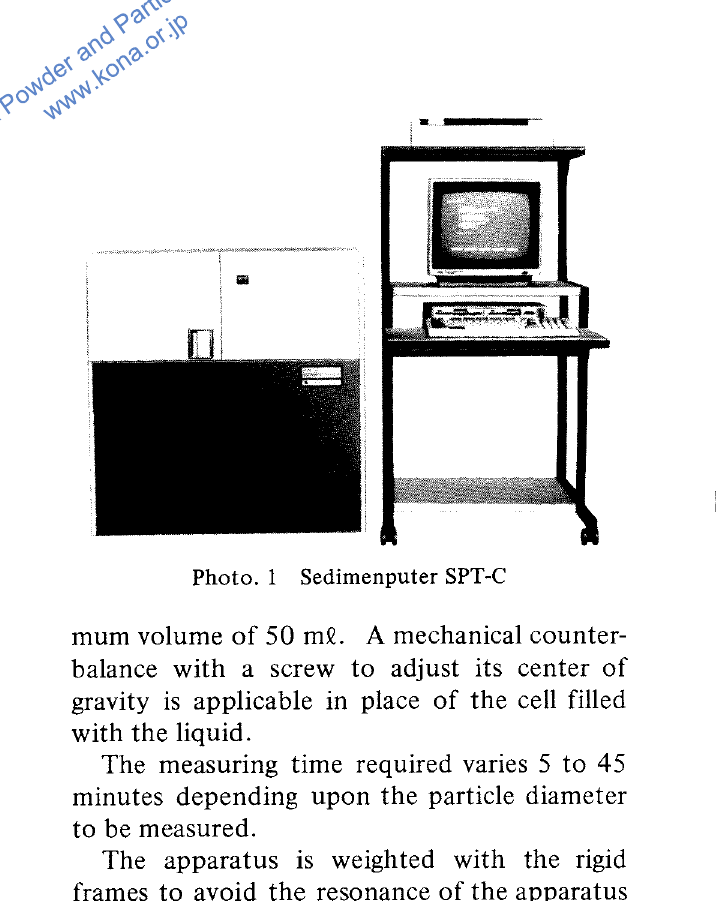
Fig. 3 Block diagram of the measuring unit